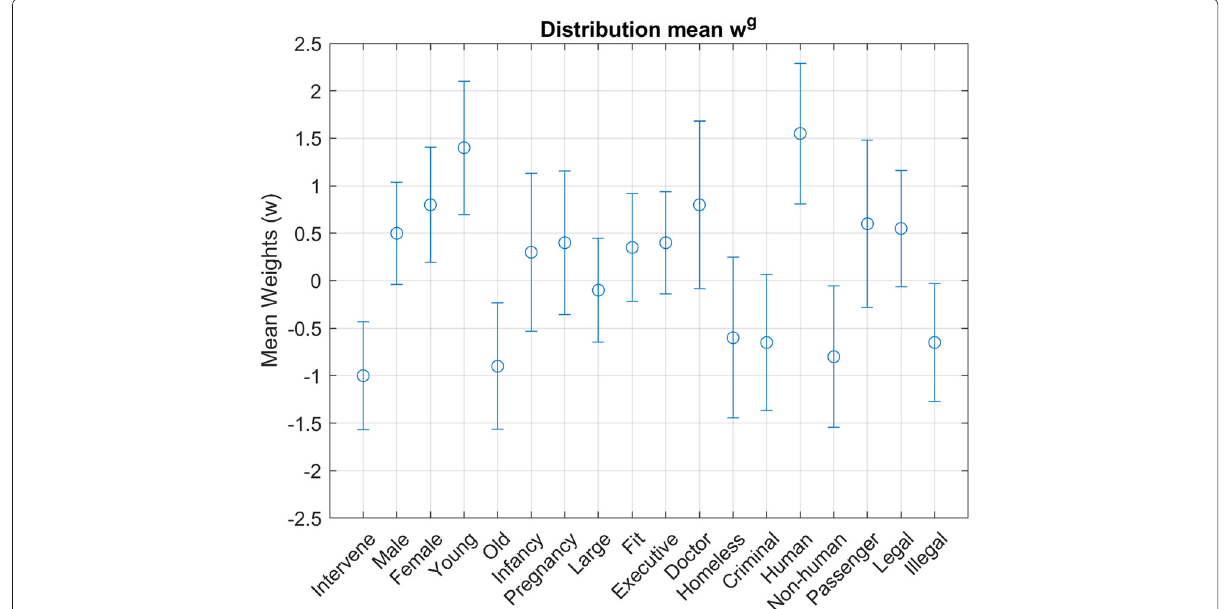
Fig. 3 Moral Principle Mean: Mean value for all underlying distributions of the moral principle vector